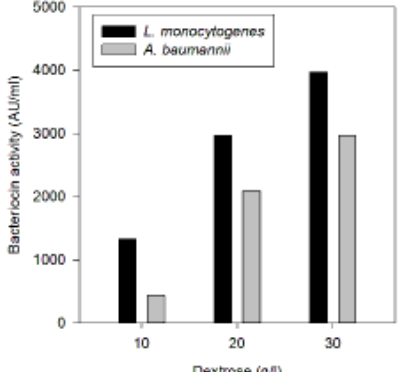
Fig. 8. Effect of dextrose on bacteriocin production